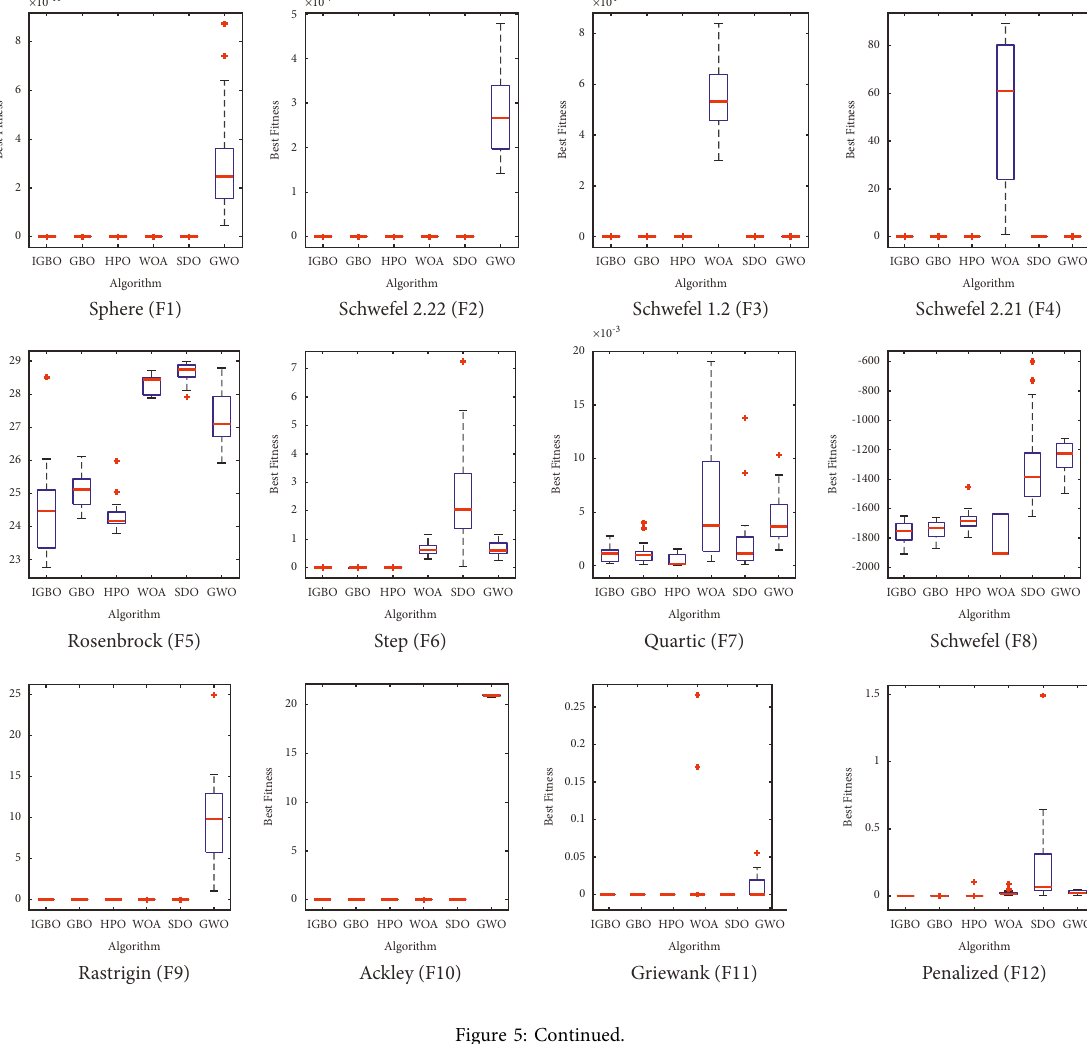
Algorithm012345 n F i t s t B e